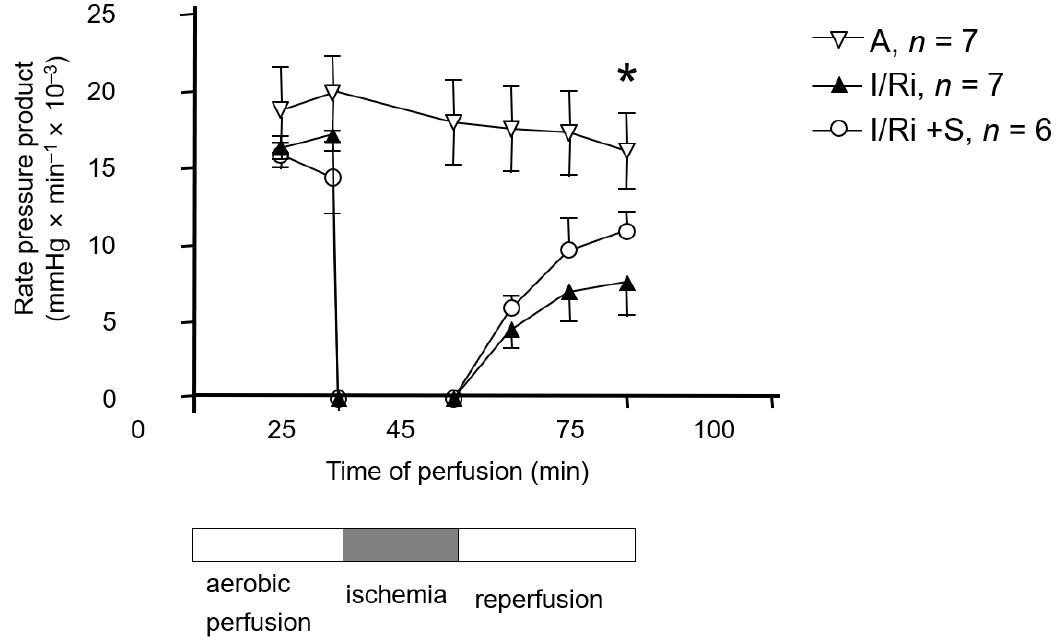
Figure 1. Effect of simvastatin on cardiac mechanical function after 20 min of ischemia. Result presented as the rate-pressure product (heart rate × left ventricular developed pressure) during reperfusion. Cardiac mechanical function at 30 min of reperfusion in I/R group was significantly impaired in comparison to control group but did not differ from the one of aerobically perfused hearts in simvastatin-treated group. A—aerobic perfusion, IRi—ischemia-reperfusion injury, IRi + S—hearts from IR injury model treated with simvastatin. * p < 0.05, n = 6–7, ANOVA.